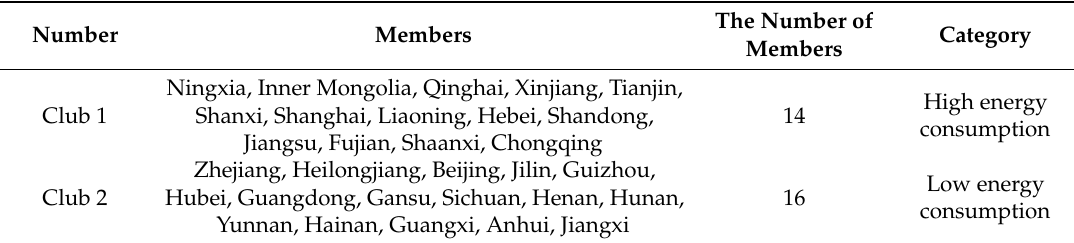
Table 4. Grouping of clubs.